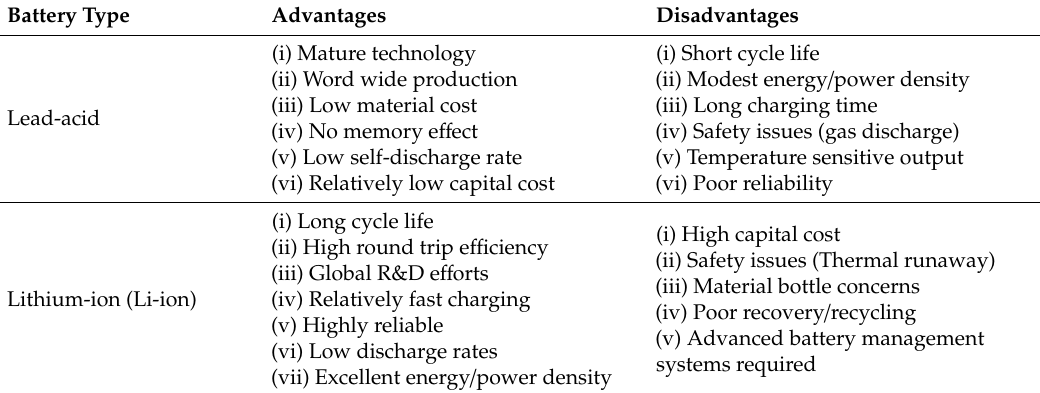
Table 7. Advantages and disadvantages of di ff erent battery systems modified from